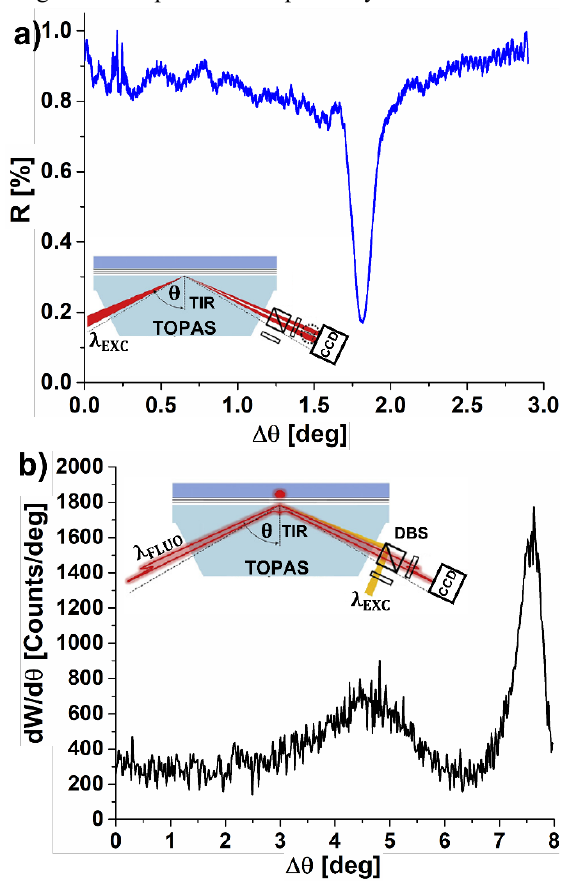
Fig. 1 – The reflectance spectrum shown in (a) has been recorded with Phosphate Buffered Saline 1x inside the microfluidics (represented by the dark blue layer in the inset). The inset of (a) depicts the light path through the biochip cross- section and light recording system in Label-Free configuration . (b) shows the angular fluorescence intensity emitted by Qdot TM 655 at the surface of the 1DPC. The inset of (b) shows the fluorescence excitation scheme where the fluorescence emitted is collected with a remarkable